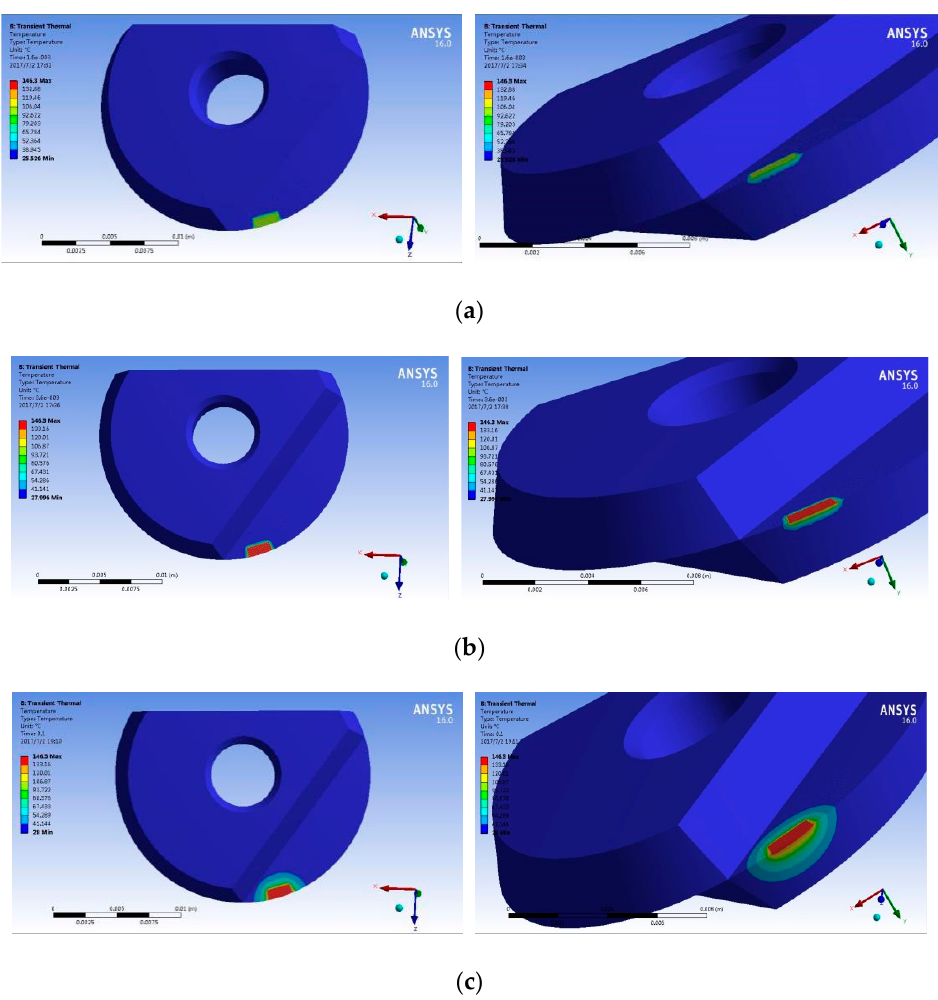
Figure 11. Changes in the temperature field over time. ( a ) t = 0.0016 s; ( b ) t = 0.0036 s; ( c ) t = 0.1 s.